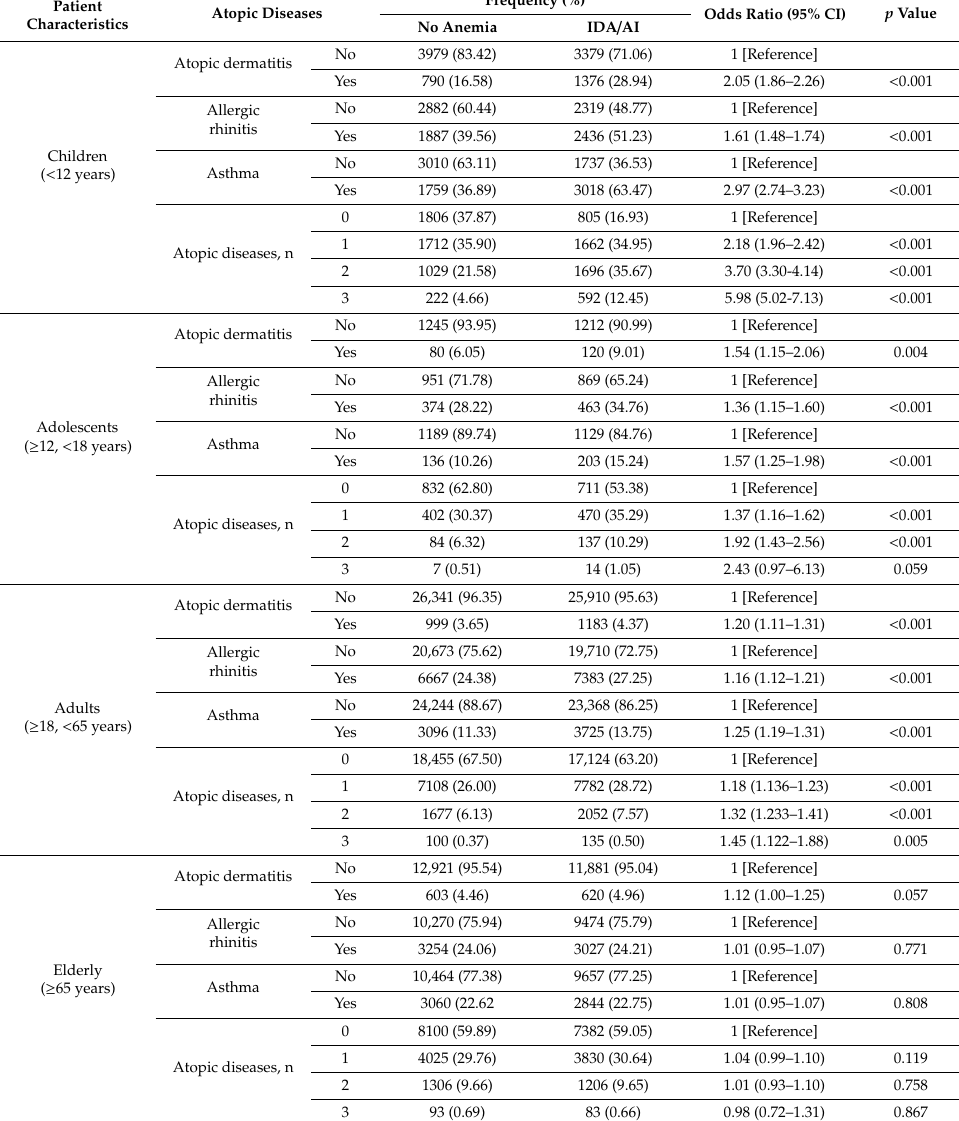
Table 3. Subgroup analysis of associations between atopic diseases and anemia. Patient